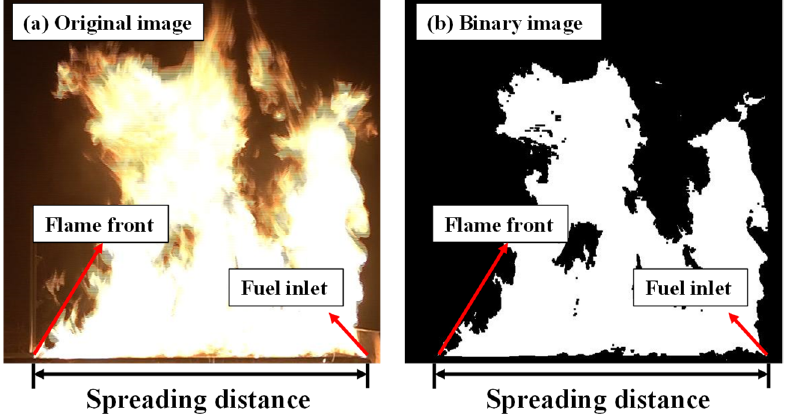
Figure 2. A schematic diagram of the flame processing method: ( a ) original image, ( b ) binary image.